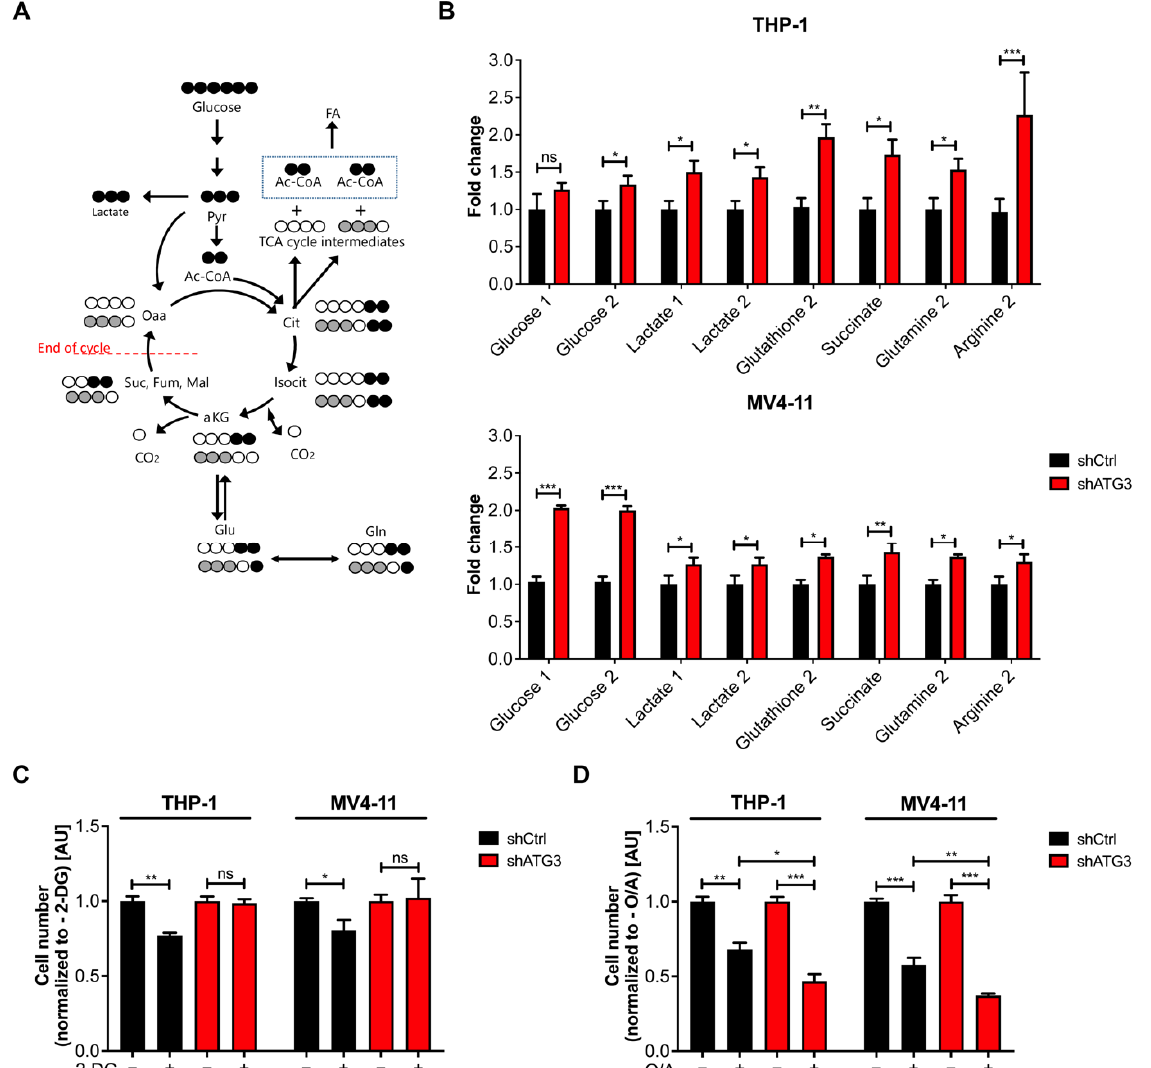
Figure 5. Loss of ATG3 activates glucose metabolism and TCA cycle but sensitizes AML cells to mitochondrial inhibition. ( A ) Carbon atom transition map when using [U- 13 C 6 ]-glucose as a tracer. Pyruvate entry into mitochondria can take place in two ways: via pyruvate dehydrogenase (PDH) or via pyruvate carboxylase (PC). For each metabolite, black molecules demonstrate the 13 C labeling pattern of Ac-CoA entry into TCA cycle by PDH corresponding to the first cycle of oxidation. On the other hand, gray molecules indicate the pyruvate entry into TCA cycle by PC. For clarity reasons, only the first turn of TCA cycle is depicted here. ( B ) Fold change of indicated metabolites normalized to control (shCtrl) of indicated metabolites analyzed by tracer-based NMR using [U- 13 C 6 ]-glucose. ( C ) Cell growth analysis of THP-1 and MV4-11 control and ATG3-depleted cells in the presence or absence of 1 mM 2-DG or ( D ) 2 μ M (THP-1) or 1 μ M (MV4-11) oligomycin and antimycin A (O/A, 1:1 ratio). Cells were incubated for 24 h with inhibitors and counted afterwards using trypan blue exclusion. Cell numbers were normalized to untreated conditions. Student’s t test was performed in ( B – D ). Error bars represent SEM. ns, not significant, * p < 0.05, ** p < 0.01, *** p < 0.001.